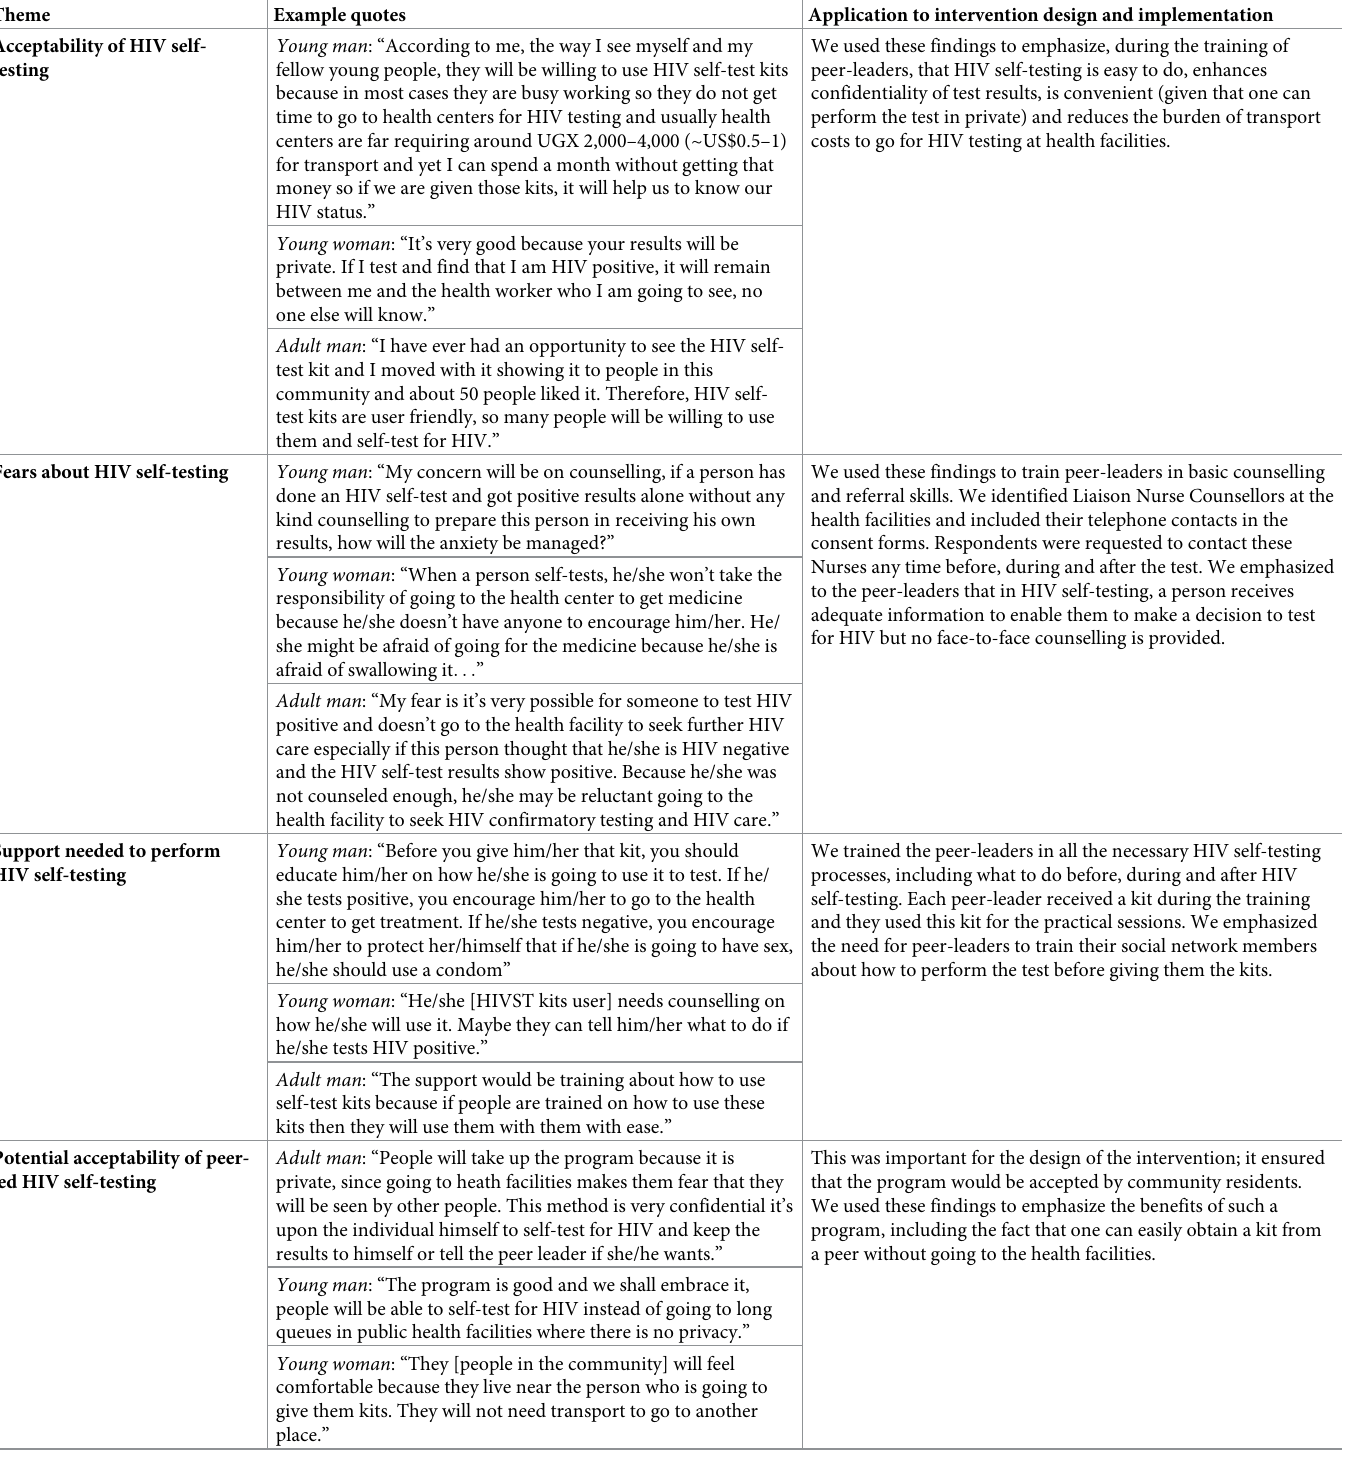
Table 1. Focus group themes and quotes that informed the design of the intervention.